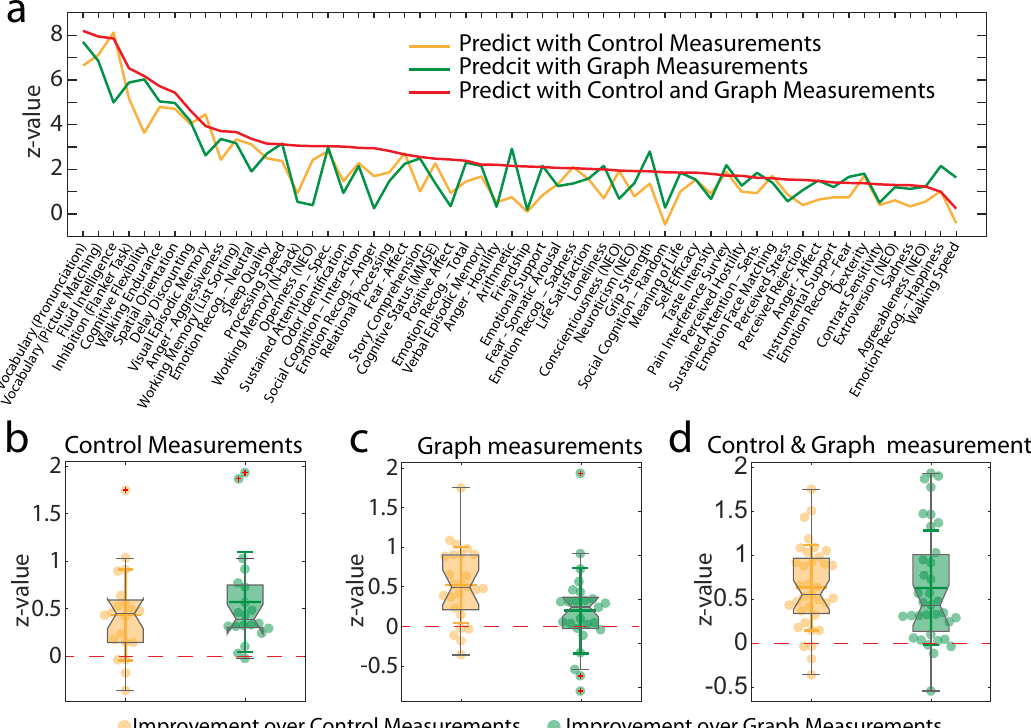
Fig. 5 Complementary power of graph and control theoretical measurements in predicting behavioral scores. We demonstrate the gain of predictive power by using a pair of features combining both graph and control theoretical measurements over using features chosen from either graphical or controllability measurements. a The improvement is positive for 41 of 58 tasks over the input features selected from either control or graph-theoretical measurements. In (b – d ), we further examine the prediction improvement separately on three groups. We exhibit the distribution of prediction improvement on the task scores b that can be signi fi cantly predicted by control measurements, c that can be signi fi cantly predicted by graph measurements, and d that can be signi fi cantly predicted by the combination of the control and graph measurements. We say the score can be signi fi cantly predicted when the correlation of the predicated and observed scores is signi fi cant with p < 0 : 05. The prediction improvement in ( b – d ) is calculated as the z-values of the difference of correlations between the predicted and observed